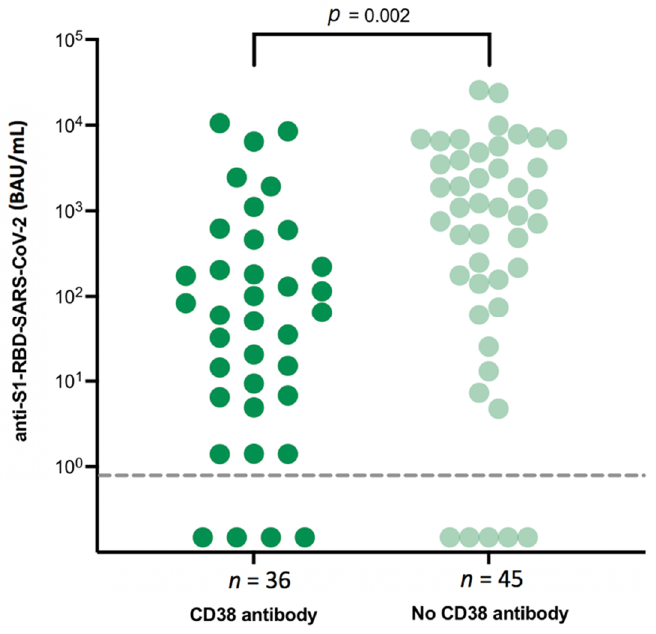
Figure 1. Serological response depending on concomitant anti-CD38-directed treatment.